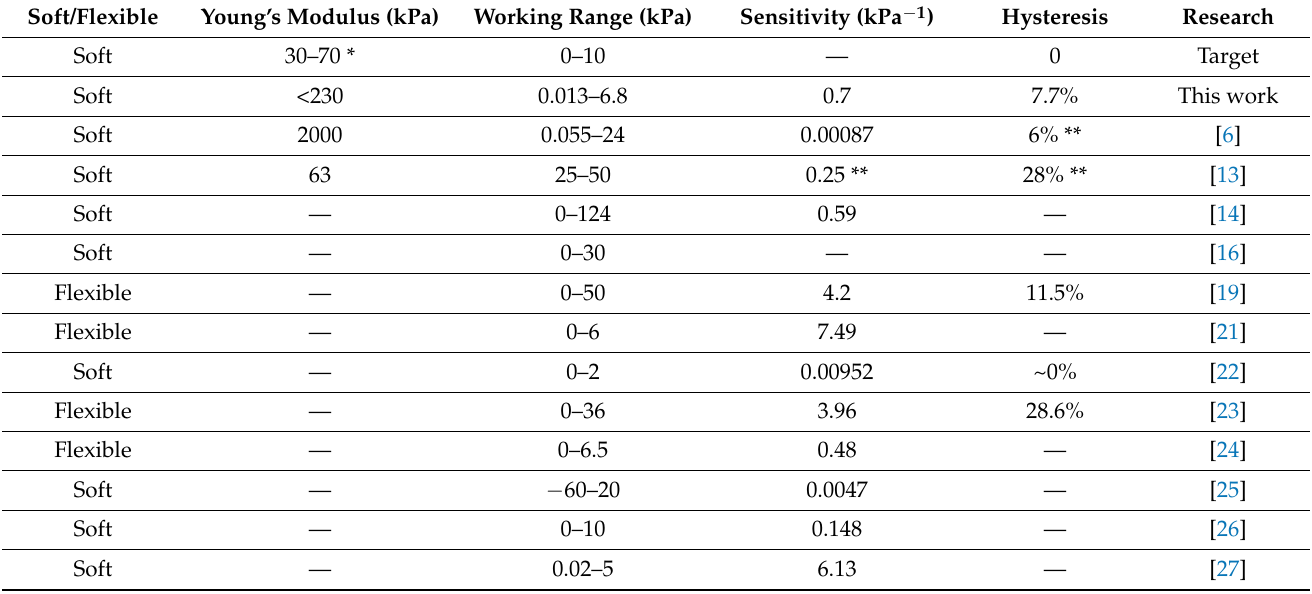
Table 1. Benchmark of the cell-structured sensor against typical sensors in the